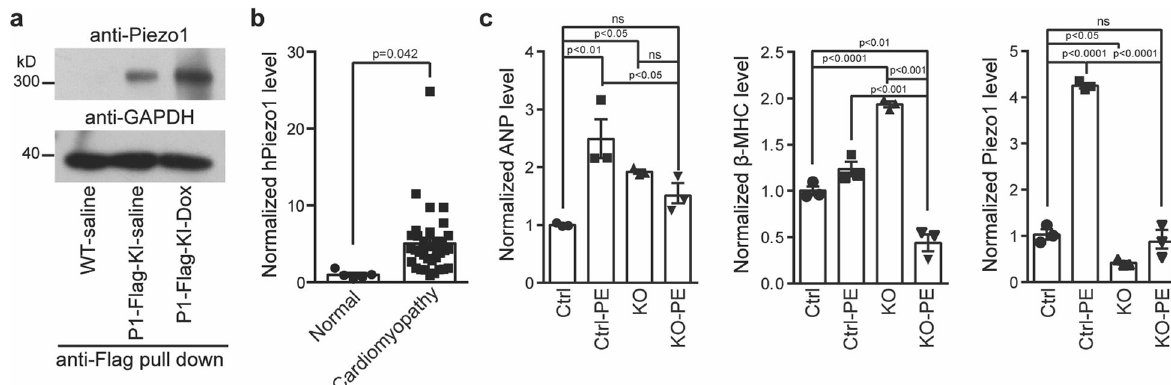
Fig. 8 Autonomic upregulation of Piezo1 contributes to the development of cardiomyopathy. a Western blotting of the anti-Flag-pulled-down Piezo1 proteins from adult cardiomyocytes derived from saline-treated wild-type mice or the Piezo1-Flag-KI mice treated with or without doxorubicin (Dox), which was used for inducing dilated cardiomyopathy. Similar results were obtained from 4 independent experiments. b RT-PCR analysis of the normalized mRNA level of human Piezo1 derived from either normal human hearts ( n = 5) or hearts with hypertrophic obstructive cardiomyopathy ( n = 35). Unpaired student ’ s t-test. Values are mean ± SEM. c RT-PCR analysis of the normalized mRNA level of the cardiac hypertrophic genes and Piezo1 in primary neonatal ventricular myocytes derived from either control or Piezo1-KO mice treated with or without phenylephrine (PE) for 24 h, which was used for inducing cardiac hypertrophy. mRNA levels were normalized by GAPDH levels. Data from 3 independent experiments. One-way ANOVA. Values are mean ±